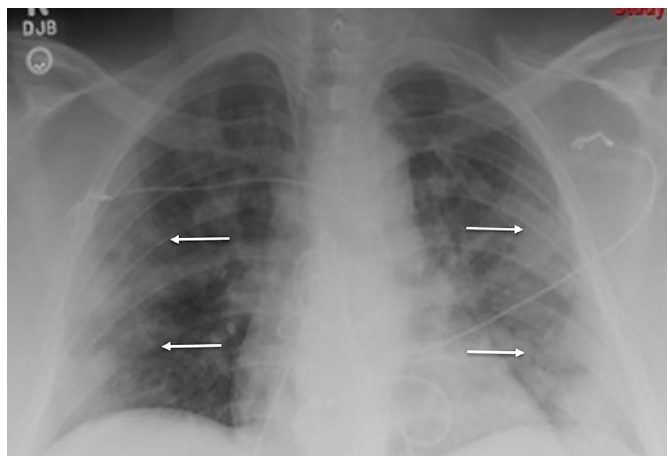
Image 3. Initial chest radiograph of a patient with COVID-19 showing scattered, bilateral, hazy airspace opacities (indicated by the